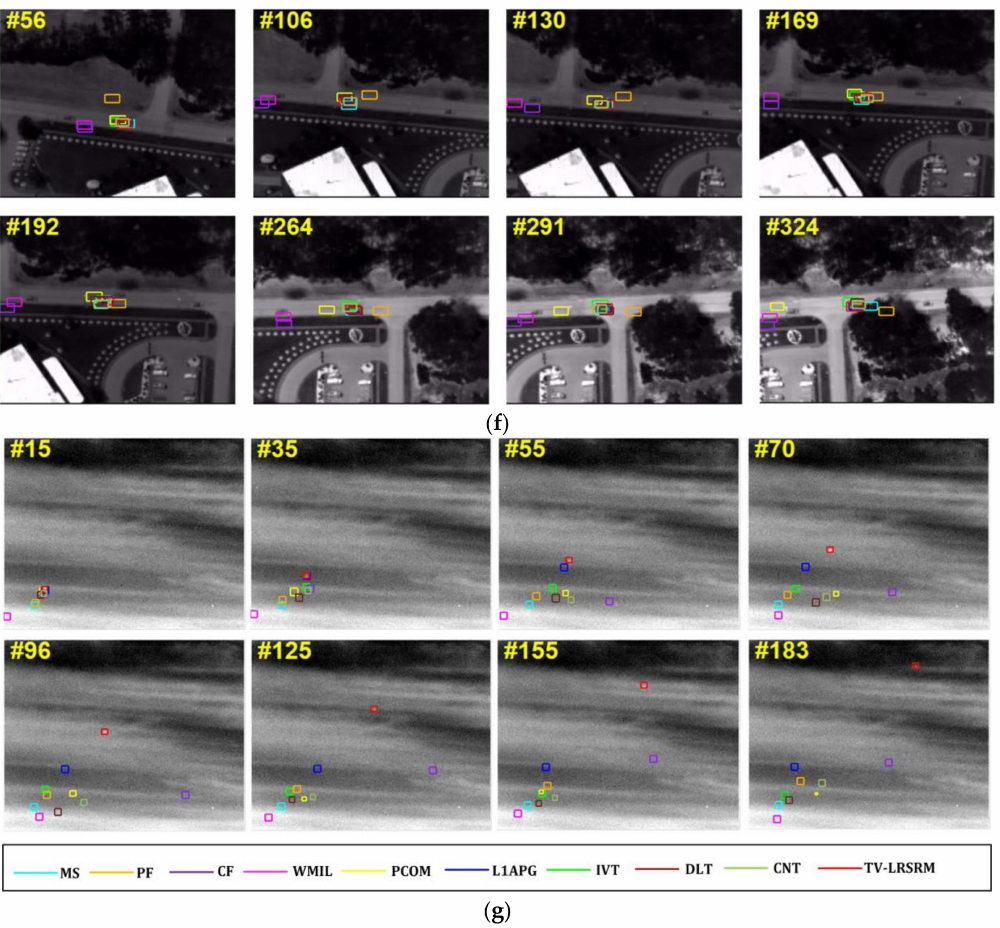
Figure 3. ( a ) Tracking results of Seq.1. ( b ) Tracking results of Seq.2. ( c ) Tracking results of Seq.3. ( d ) Tracking results of Seq.4. ( e ) Tracking results of Seq.5. ( f ) Tracking results of Seq.6. ( g ) Tracking results of